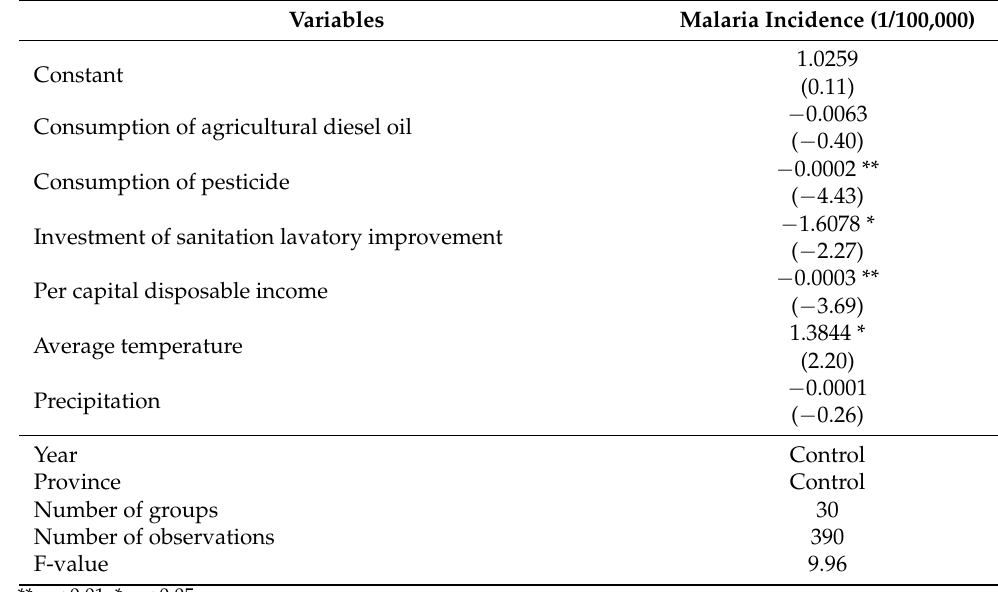
Table 4. Results of fixed effects regression